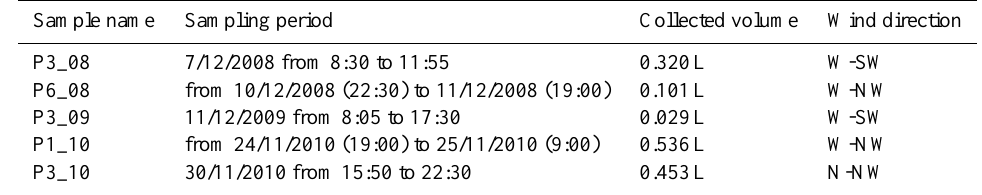
Table 2a. Sampling conditions for the non-contaminated rain events. The funnel collecting surface is 0.045m 2 .